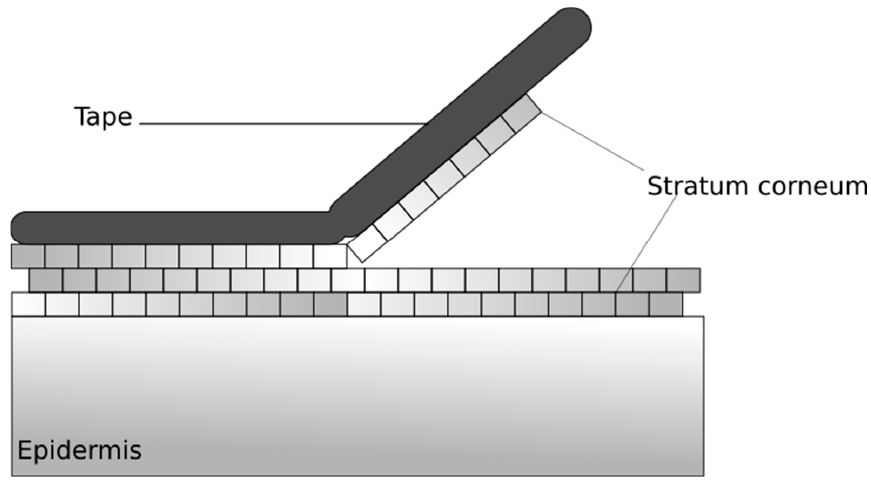
Figure 9. Layers of the stratum corneum are removed by an adhesive tape.